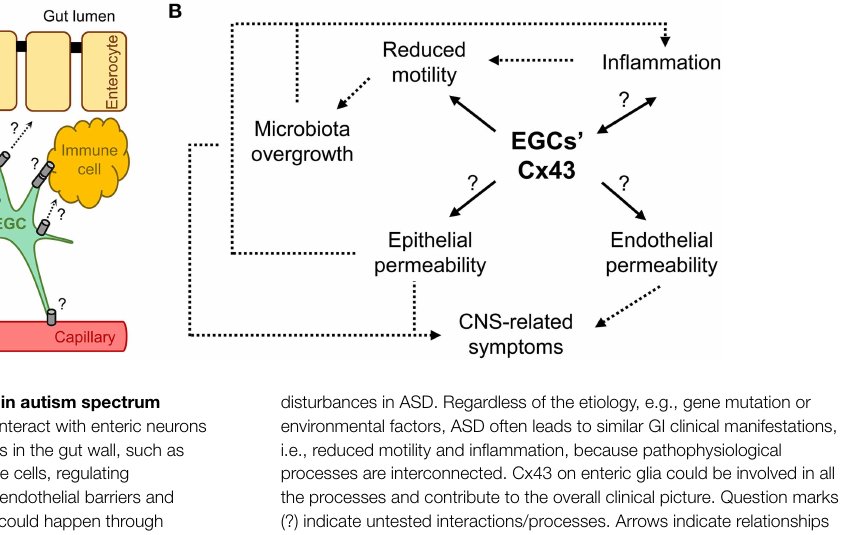
disturbances in ASD. Regardless of the etiology, e.g., gene mutation or environmental factors, ASD often leads to similar GI clinical manifestations, i.e., reduced motility and inflammation, because pathophysiological processes are interconnected. Cx43 on enteric glia could be involved in all the processes and contribute to the overall clinical picture. Question marks (?) indicate untested interactions/processes. Arrows indicate relationships between the processes (dashed lines indicate processes not directly linked to EGCs’